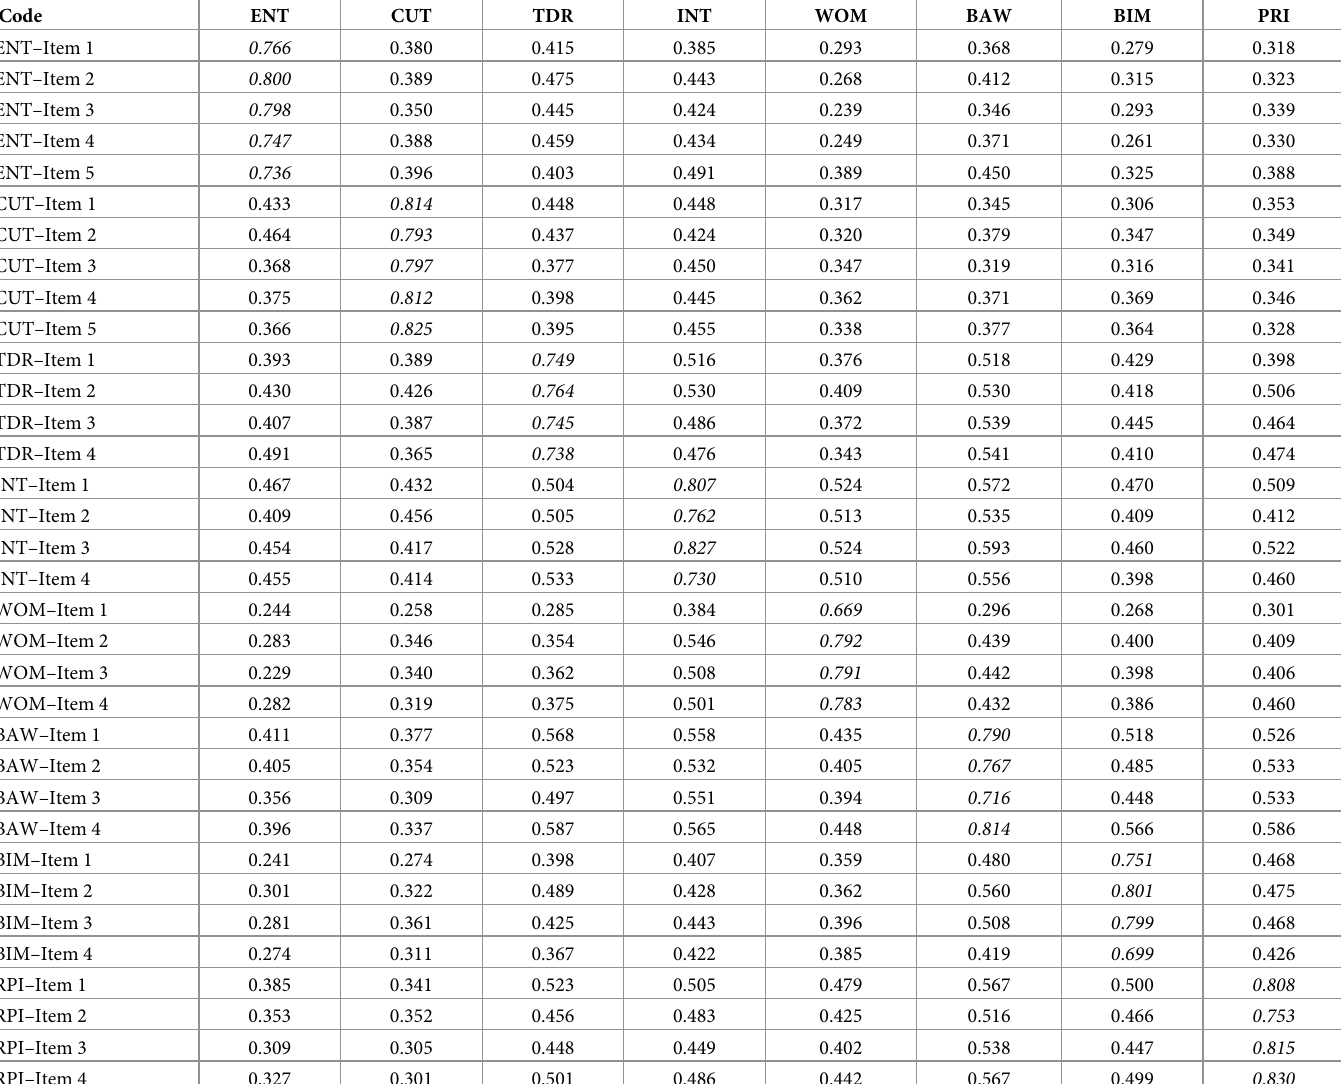
Table 5. Loadings and